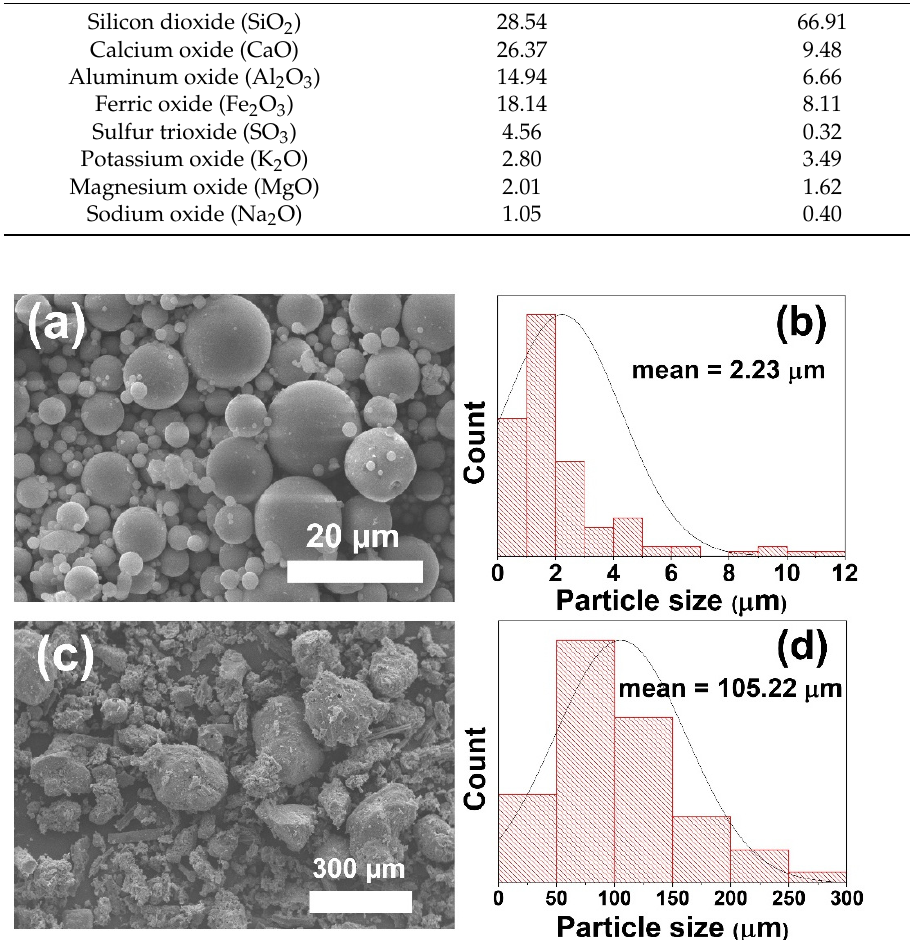
Figure 2. SEM micrographs and particle size distribution curves for ( a , b ) raw FA, and ( c , d ) treated SCBA.